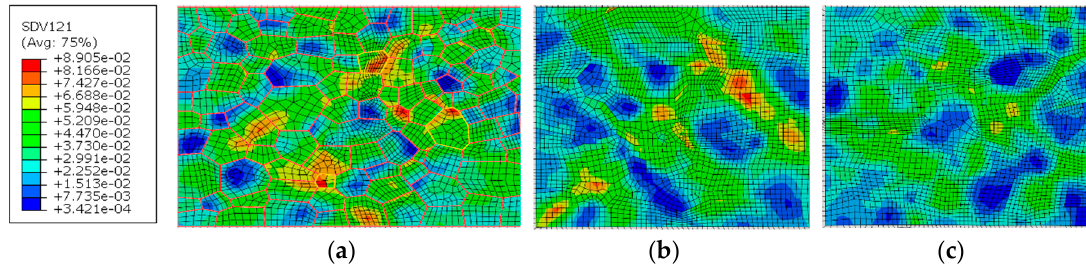
Figure 11. Cumulative shear strains of all slip systems: ( a ) WNZ, ( b ) TMAZ, and ( c ) HAZ.